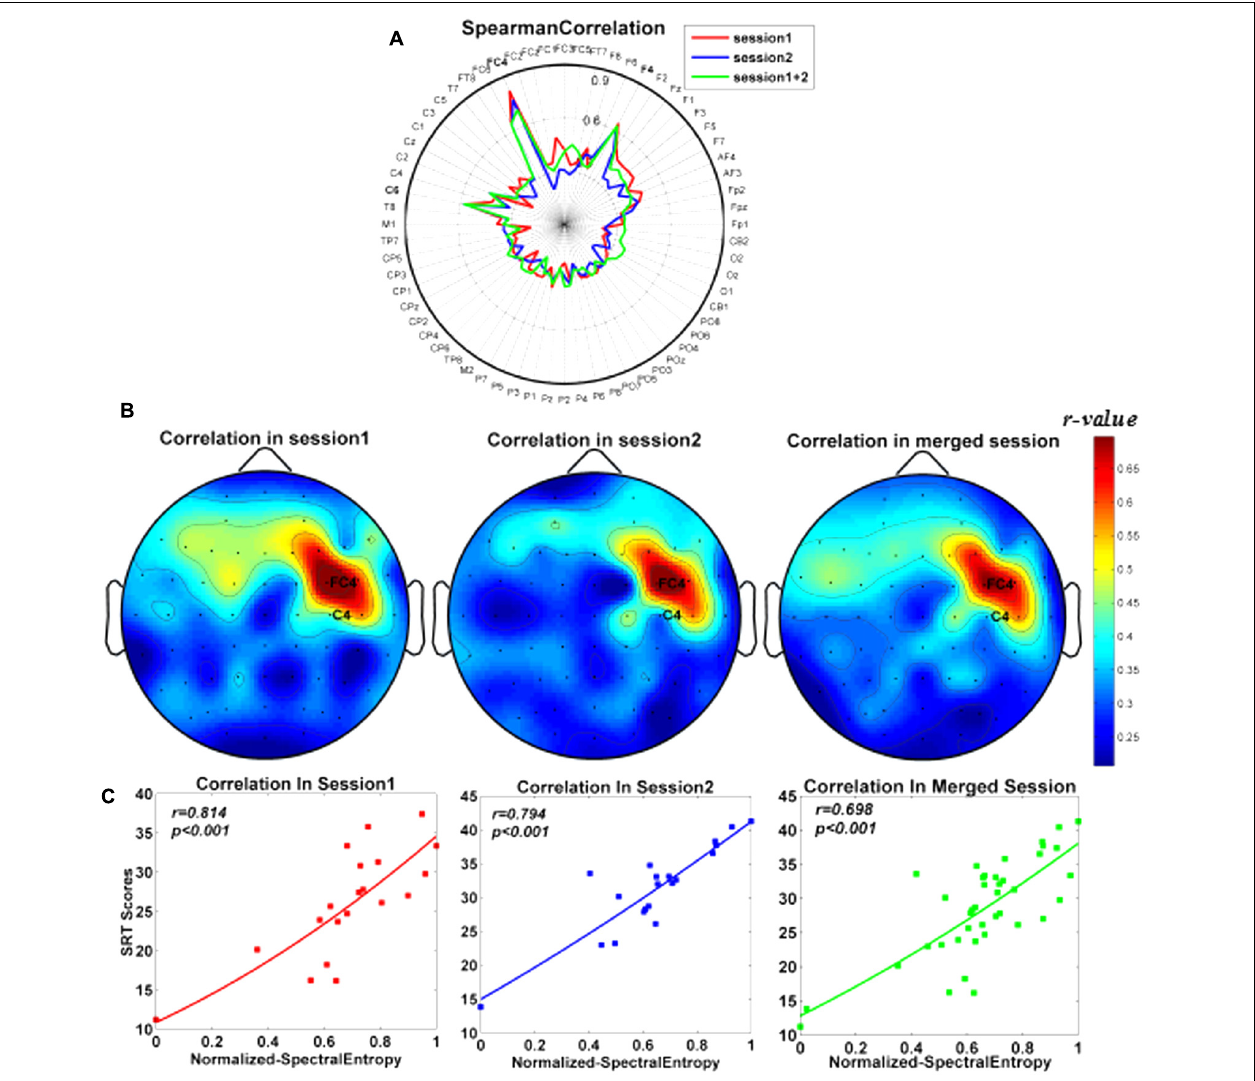
FIGURE 3 | Scalp spatial distribution for correlations between the normalized spectral entropy and subjects’ SRT scores. (A) Fingerprint maps. (B) Topographic maps. The color bar denoted the correlation values between SRT scores and spectral entropy. (C) Correlations between SRT scores and spectral entropy on channel FC4 separately in session 1, session 2, and merged session.